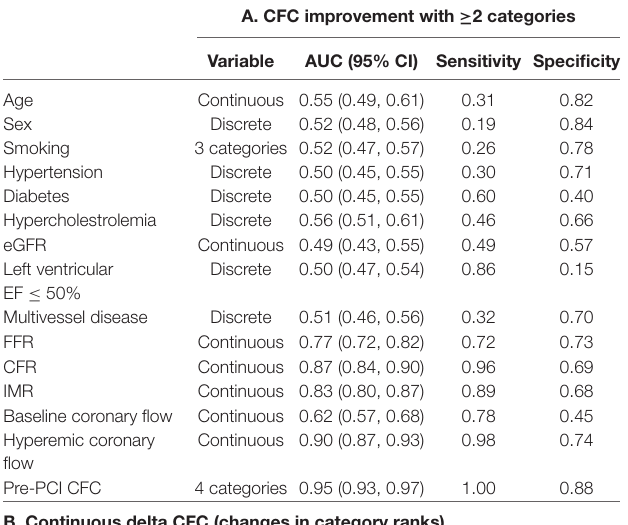
TABLE 3 | Prediction of CFC improvement by various pre-PCI